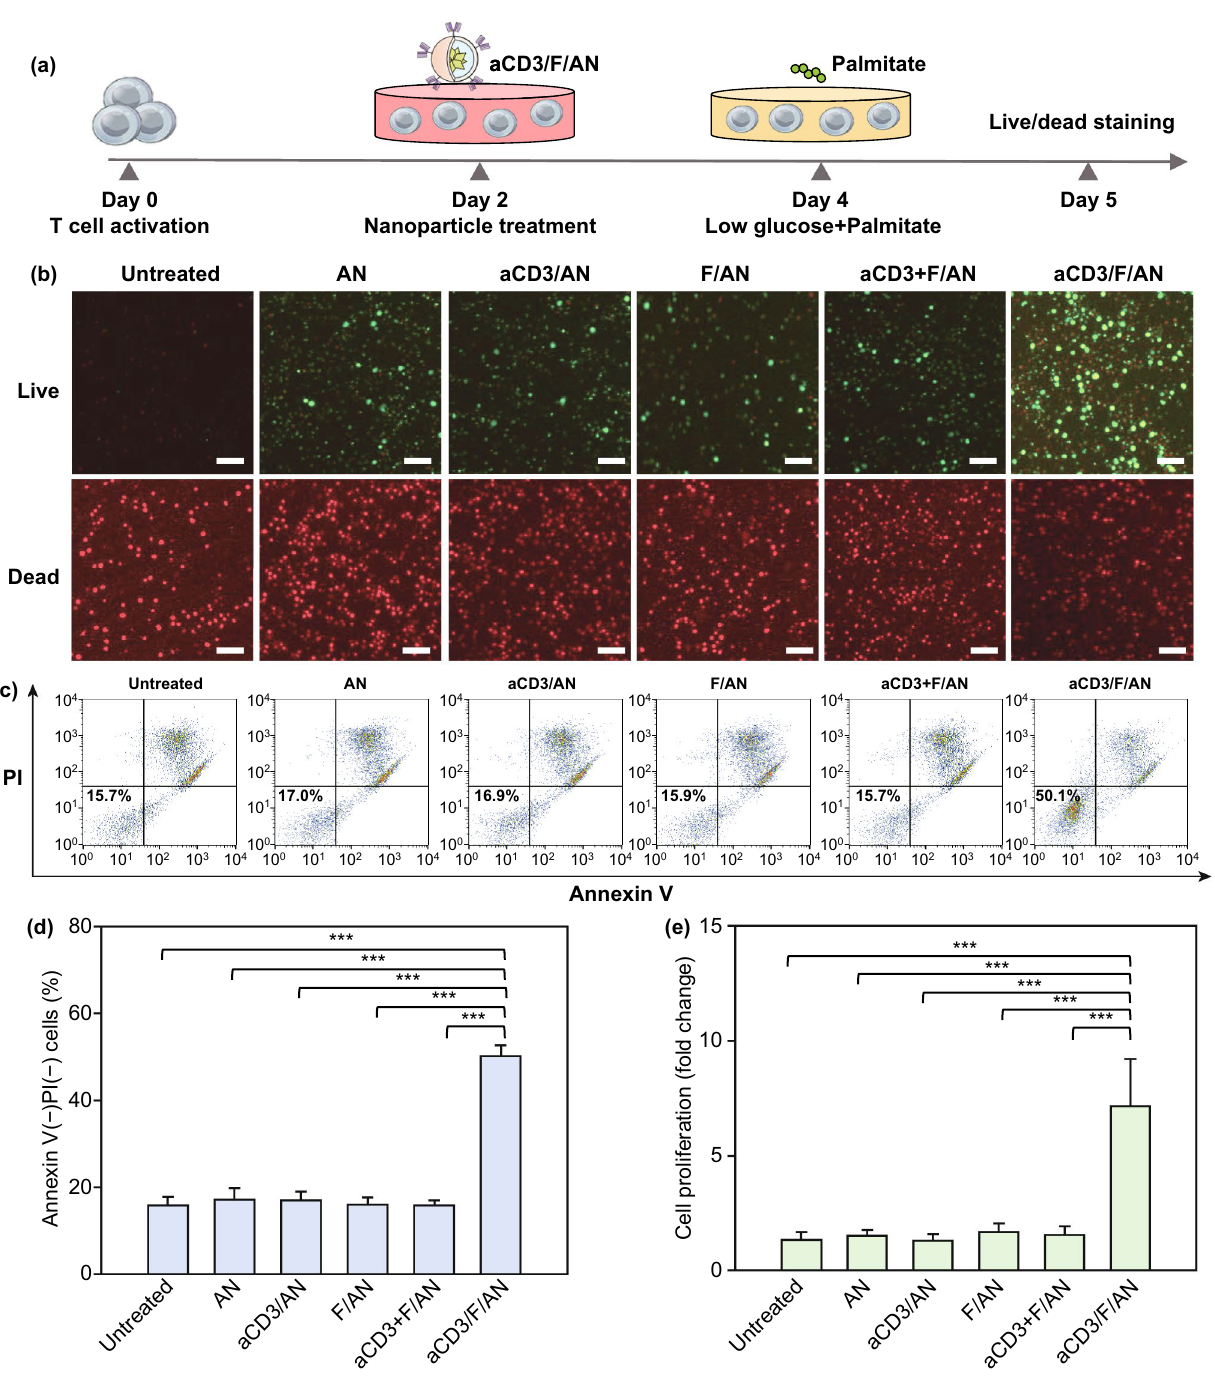
Fig. 6 Enhanced T cell survival and proliferation induced by metabolic reprogramming. T cells were activated and treated with various nano‑ particle preparations and incubated under glucose‑limiting conditions, with or without a lipid source. a Illustration of the experimental scheme. b Live and dead T cells, visualized by fluorescent dye staining. Scale bar: 10 μm. c, d T cells were stained with annexin V and PI, and the annexin V – /PI – population was quantified for each group (***P < 0.001). e Proliferation of T cells, measured using WST‑1 assays (***P <